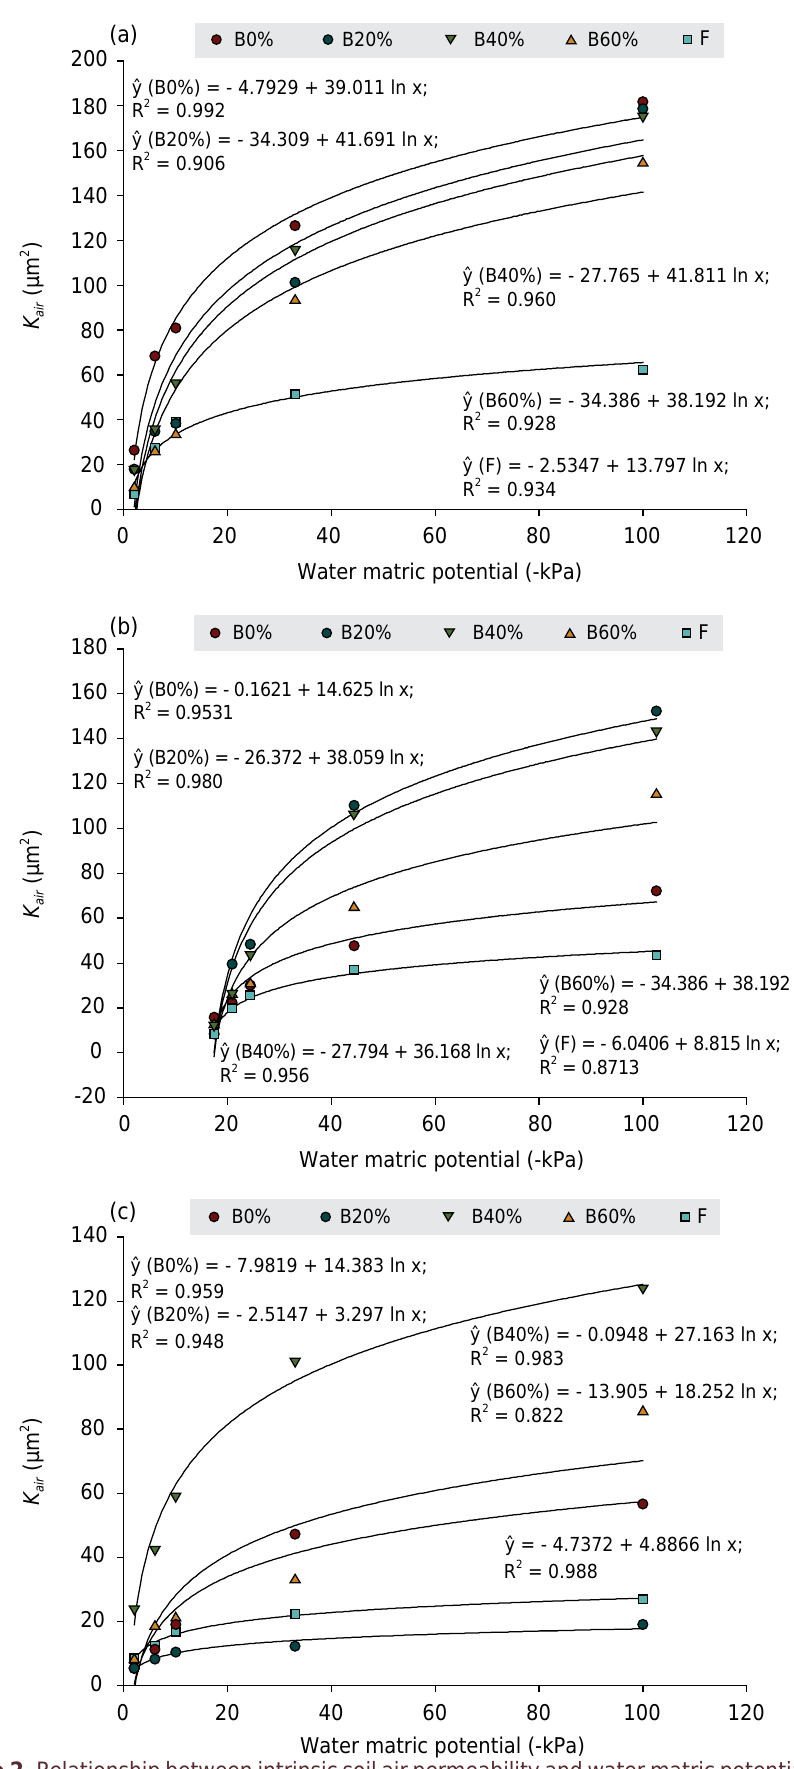
Figure 2. Relationship between intrinsic soil air permeability and water matric potential, for areas under fig cultivation and secondary native forest in the layers of 0.0-0.1 m (a), 0.1-0.2 m (b) and 0.2-0.3 m